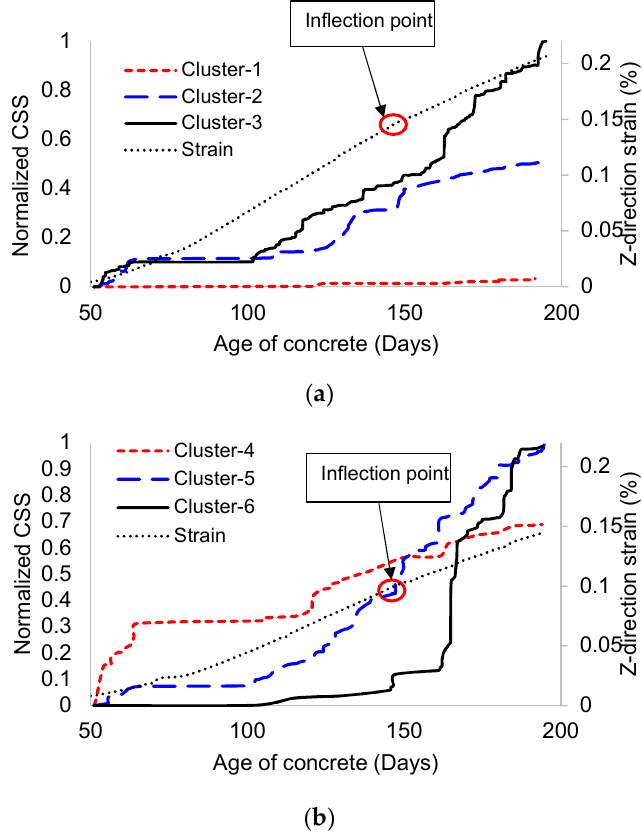
Figure 11. Normalized cumulative signal strength. ( a ) Confined specimen; ( b ) Unconfined specimen.